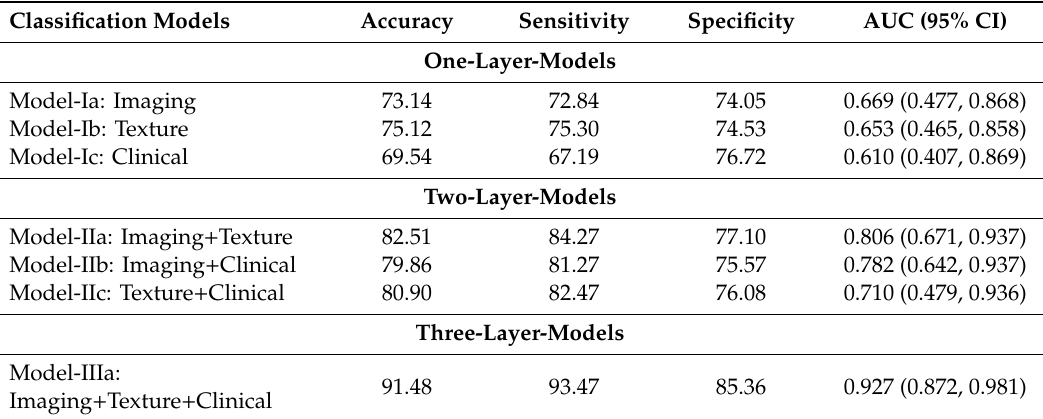
Table entries are either means or the number of patients (percentage distribution in parentheses). IDH: isocitrate dehydrogenase; 1p / 19q: deletion of chromosome arm 1p and / or 19q. Percentage for IDH calculated using only the number of patients having the corresponding status available. Table 2. Quantitative results for grade prediction in gliomas. The experiments were performed separately for one-layered models, including model-Ia (imaging features), model-Ib (texture features), and model-Ic (clinical features); for two-layered models, including model-IIa (imaging + texture features), model-IIb (imaging + clinical features), and model-IIc (texture + clinical features); and for three-layered models, including model-IIIa (imaging + texture + clinical features). AUC =